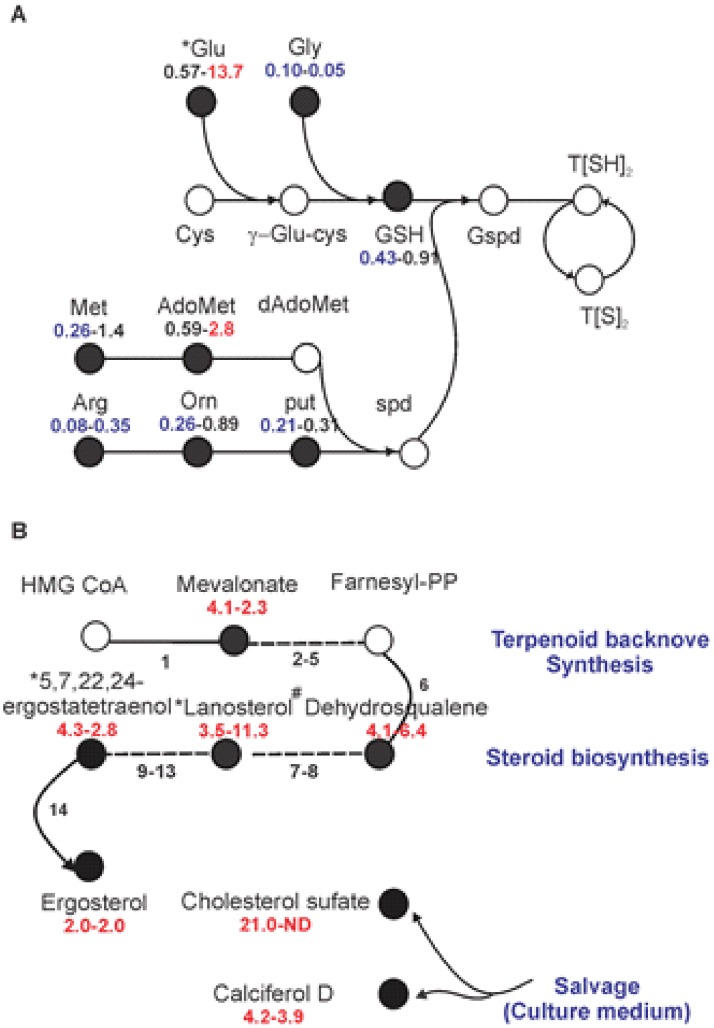
Polyamines and steroid levels in L. (V.) braziliensis Amaaxe in comparison to Prolog and Prosta.A, Schematic overview of polyamines pathway in trypanosomatids. Abbreviations are as follows: Orn, ornithine; Put, putrescine; Spd, spermidine; AdoMet, S-adenosylmethionine; dAdoMet, decarboxylated S-adenosylmethionine; GSH, reduced glutathione; T[S]2 oxidized trypanothione (trypanothion disulfide); T[SH]2 reduced trypanothione; Gspd, glutathionyl-spermidine. B, Schematic overview of terpenoid backbone synthesis and steroid biosynthesis, leading to the production of ergosterol. The dashed lines represent more than one reaction. Metabolites in empty circles were not detected in this study. The fold changes are shown below the name of each metabolite, the first number represents the signal intensity ratio for Amaaxe/Prolog and the second number represent the signal intensity ratio for Amaaxe/ Prosta. The metabolites with significant increased levels are shown in red (> 2 fold; t-test, P< 0.05), while metabolites with significant decreased levels are shown in blue (<0.5 fold; t-test, P< 0.05). The asterisk indicates that another isomer was detected for this metabolite. # Dehydrosqualene is not described in the L. donovani KEGG steroid synthesis, but is the results of linking 2 farnesyl-PP via presqualene-PP and can then be reduced to squalene. ND, No cholesterol sulfate was detected in stationary parasites.